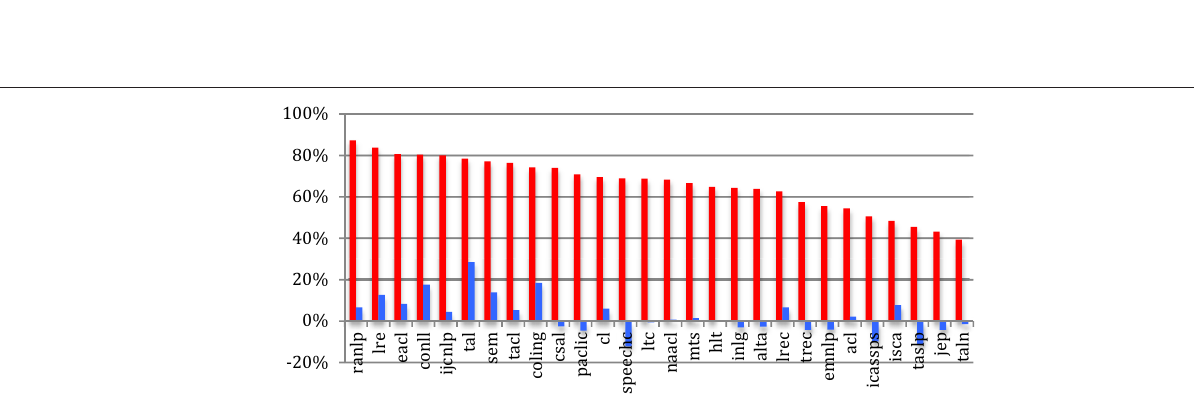
FIGURE 6 | Percentage of new authors and completely new authors over time.